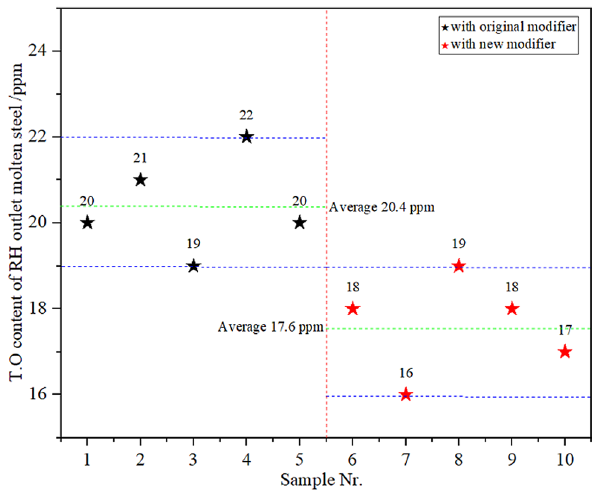
Figure 5: Total oxygen content of molten steel at the end of RH process.